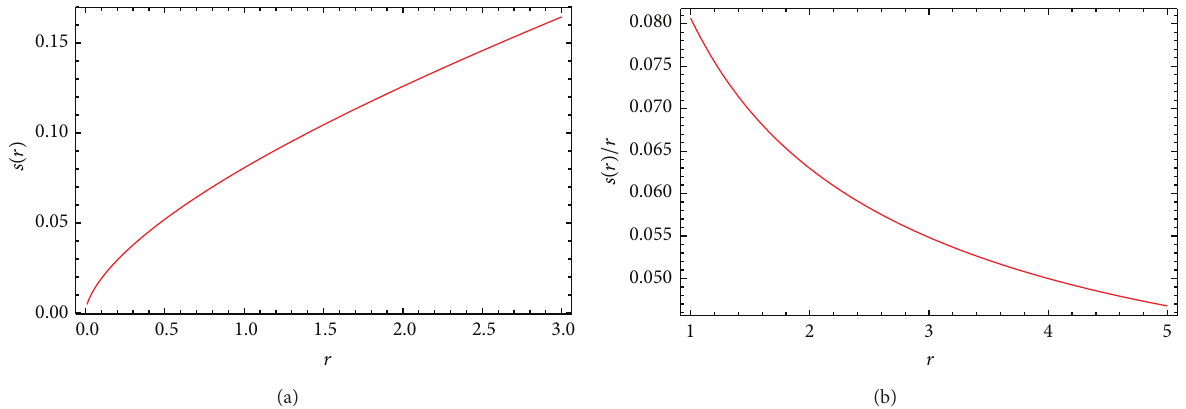
Figure 4: Plots of 𝑠(𝑟) (a) and 𝑠(𝑟)/𝑟 (b) versus 𝑟 for logarithmic model.